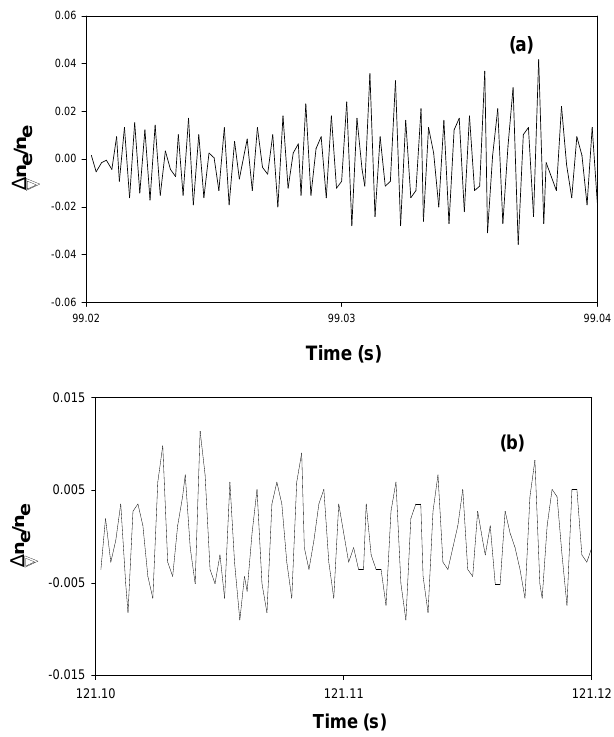
Fig. 1. Telemetry record of plasma waves obtained on 18 November 1999, (a) at an altitude of 105km and (b) at 120km altitude.